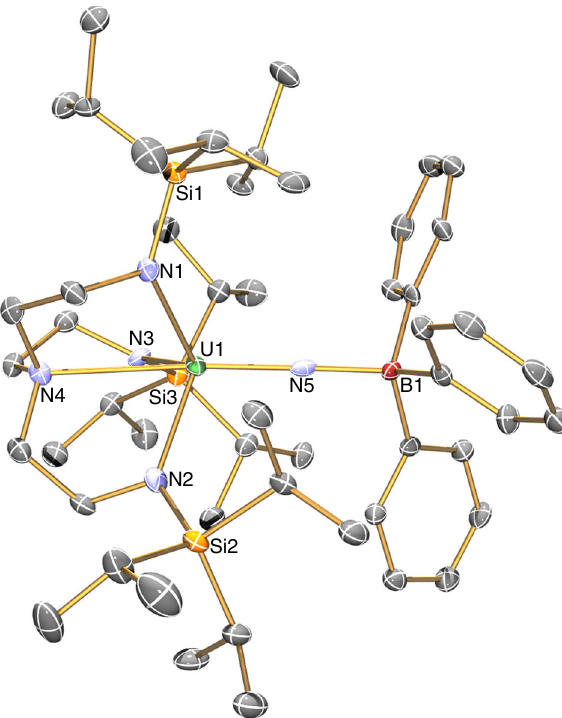
Fig. 3 Molecular structure of the anion component of 3 at 150K and displacement ellipsoids set to 40%. Hydrogen atoms, minor disorder components, lattice solvent, and the [K(B15C5) 2 ] + cation component are omitted for clarity. Selected bond lengths (Å): U1-N1, 2.305(5); U1-N2, 2.254 (7); U1-N3, 2.312(6); U1-N4, 2.737(5); U1-N5, 1.911(6); B1-N5,